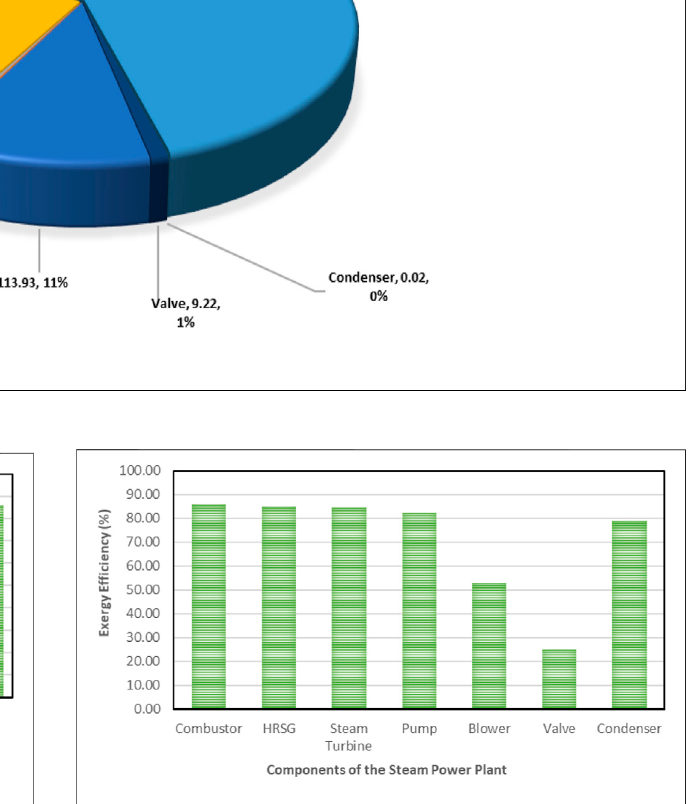
FIGURE 9 | Exergy ef fi ciency of components in the NGL recovery plant. FIGURE 10 | Exergy ef fi ciency for all the components in the steam